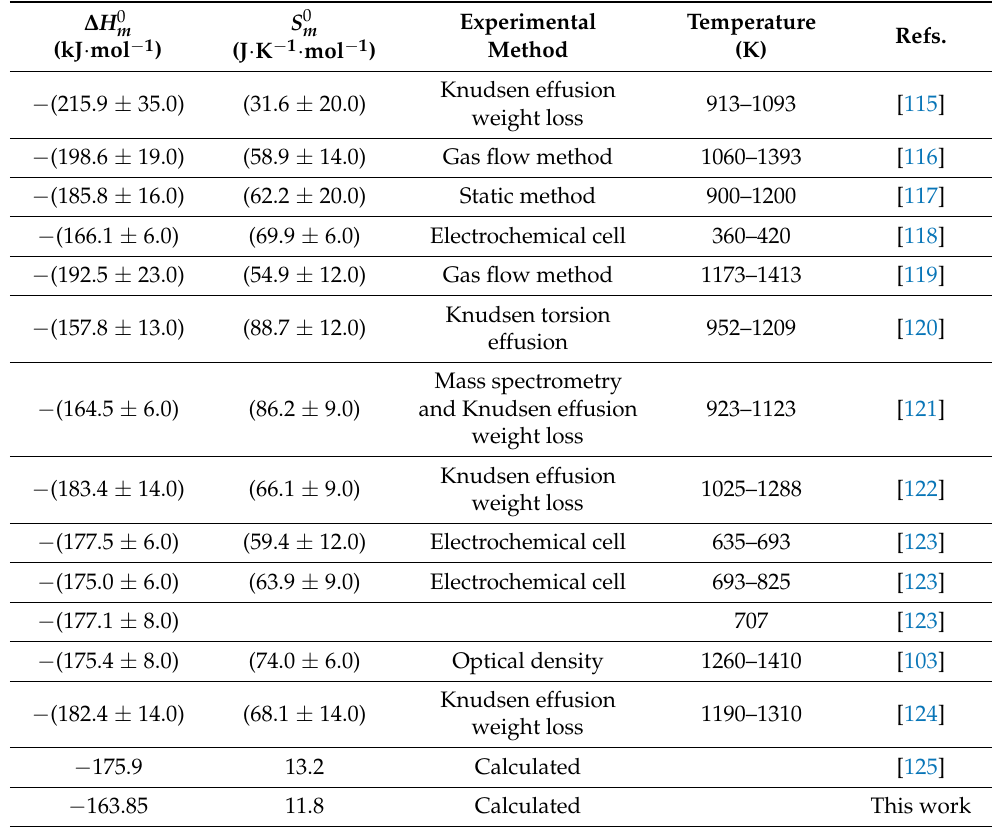
Table 3. Summary of the original experimental work [103,115–125] on the standard entropy of the α -ZnSe phase at 298.15